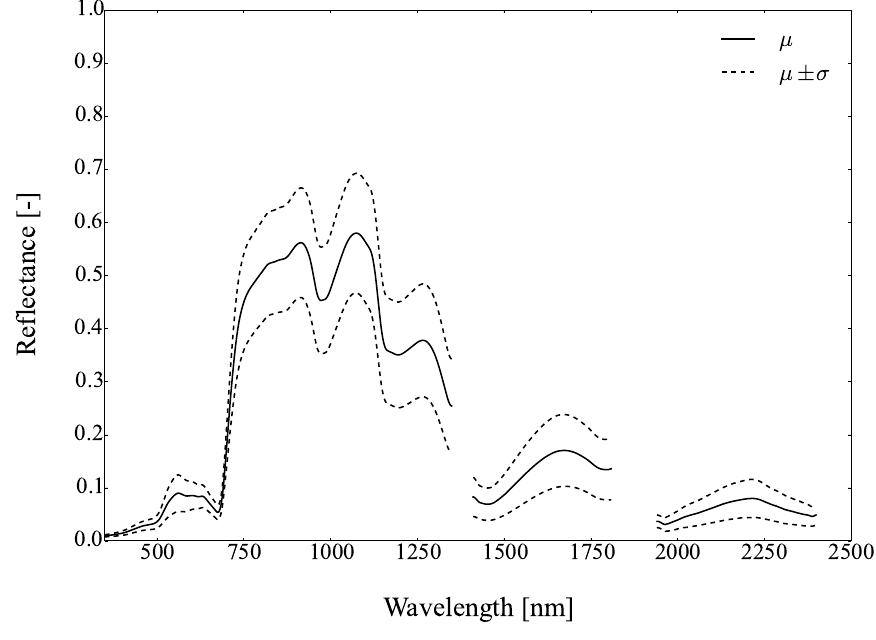
Figure A2. Mean reflectance ( µ ) and standard deviation ( σ ) of Sphagnum sp.